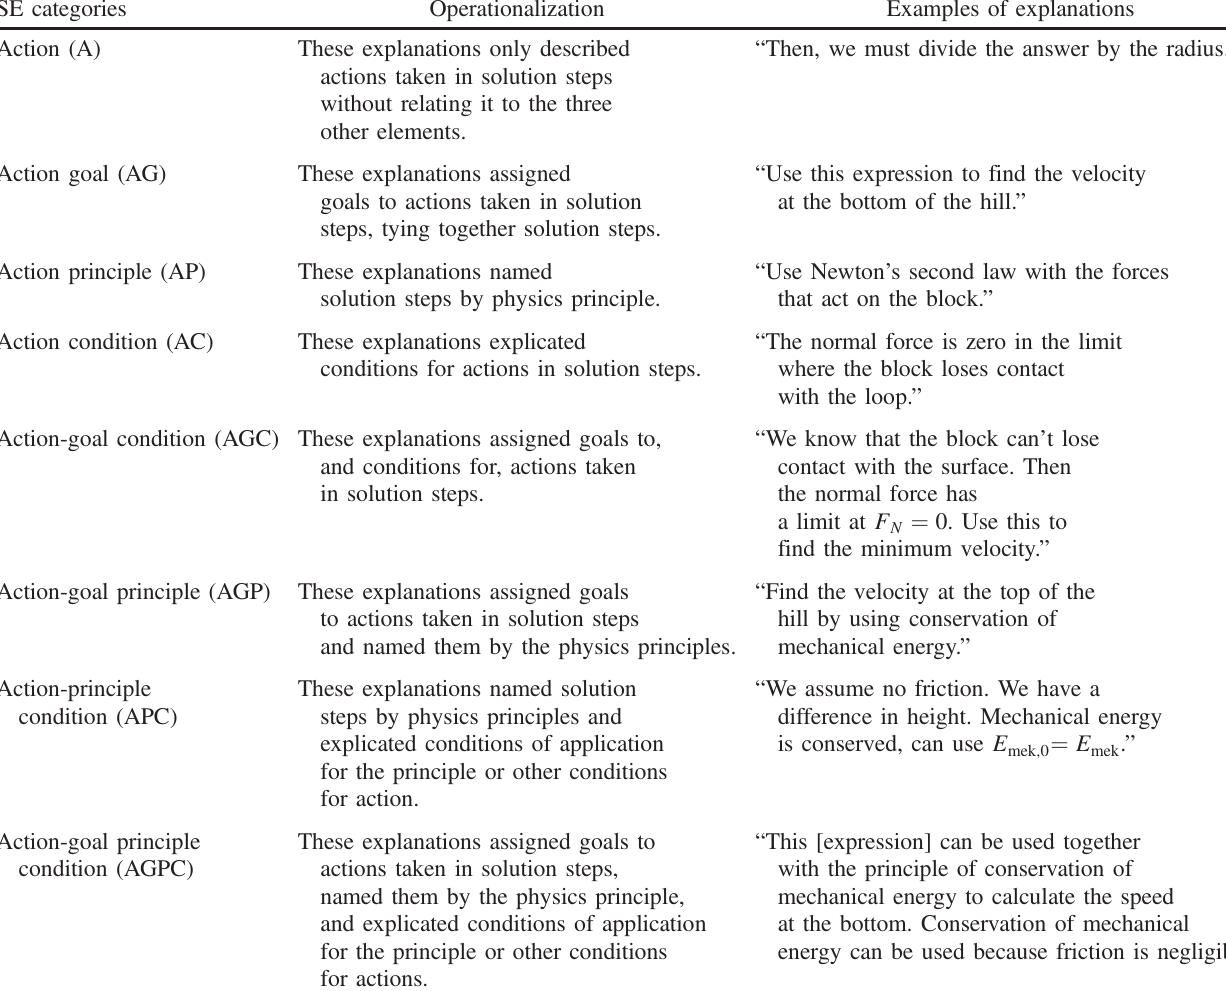
TABLE II. Examples of students ’ self-explanations of worked example solutions.